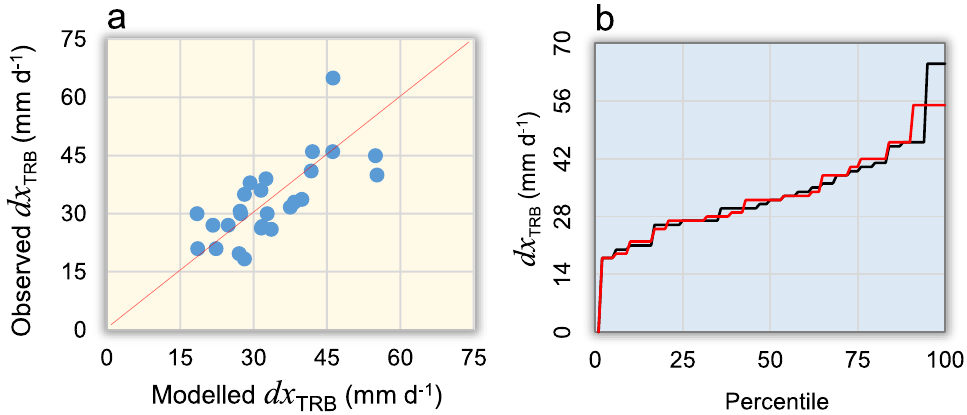
Figure 8. Observed and modelled annual maximum daily rainfall ( dx TRB ): ( A ) Scatter-plot between observed and modelled data, ( B ) the related percentile